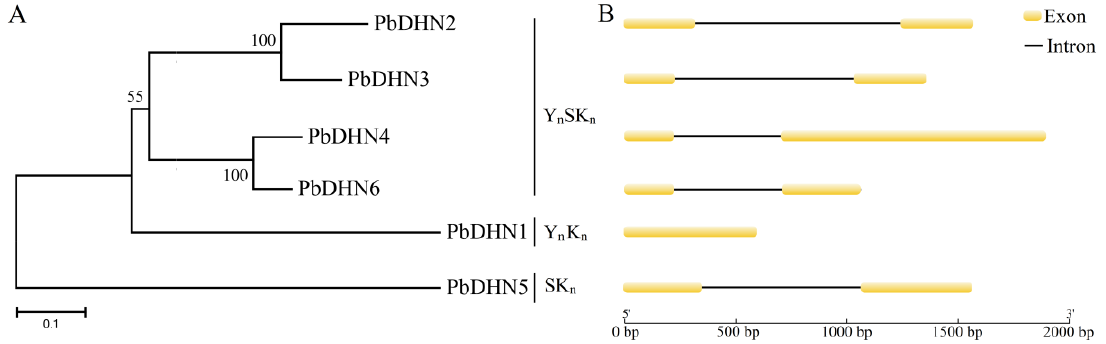
Figure 2. Phylogenetic relationships ( A ) and gene structure ( B ). The phylogenetic tree of PbDHN proteins was performed using MEGA 5.0 software with the neighbor-joining method. The bootstrap test was performed with 1000 replicates. Percentage bootstrap scores of >50% were displayed. Exons were indicated by yellow round-corner rectangles and introns by black lines.